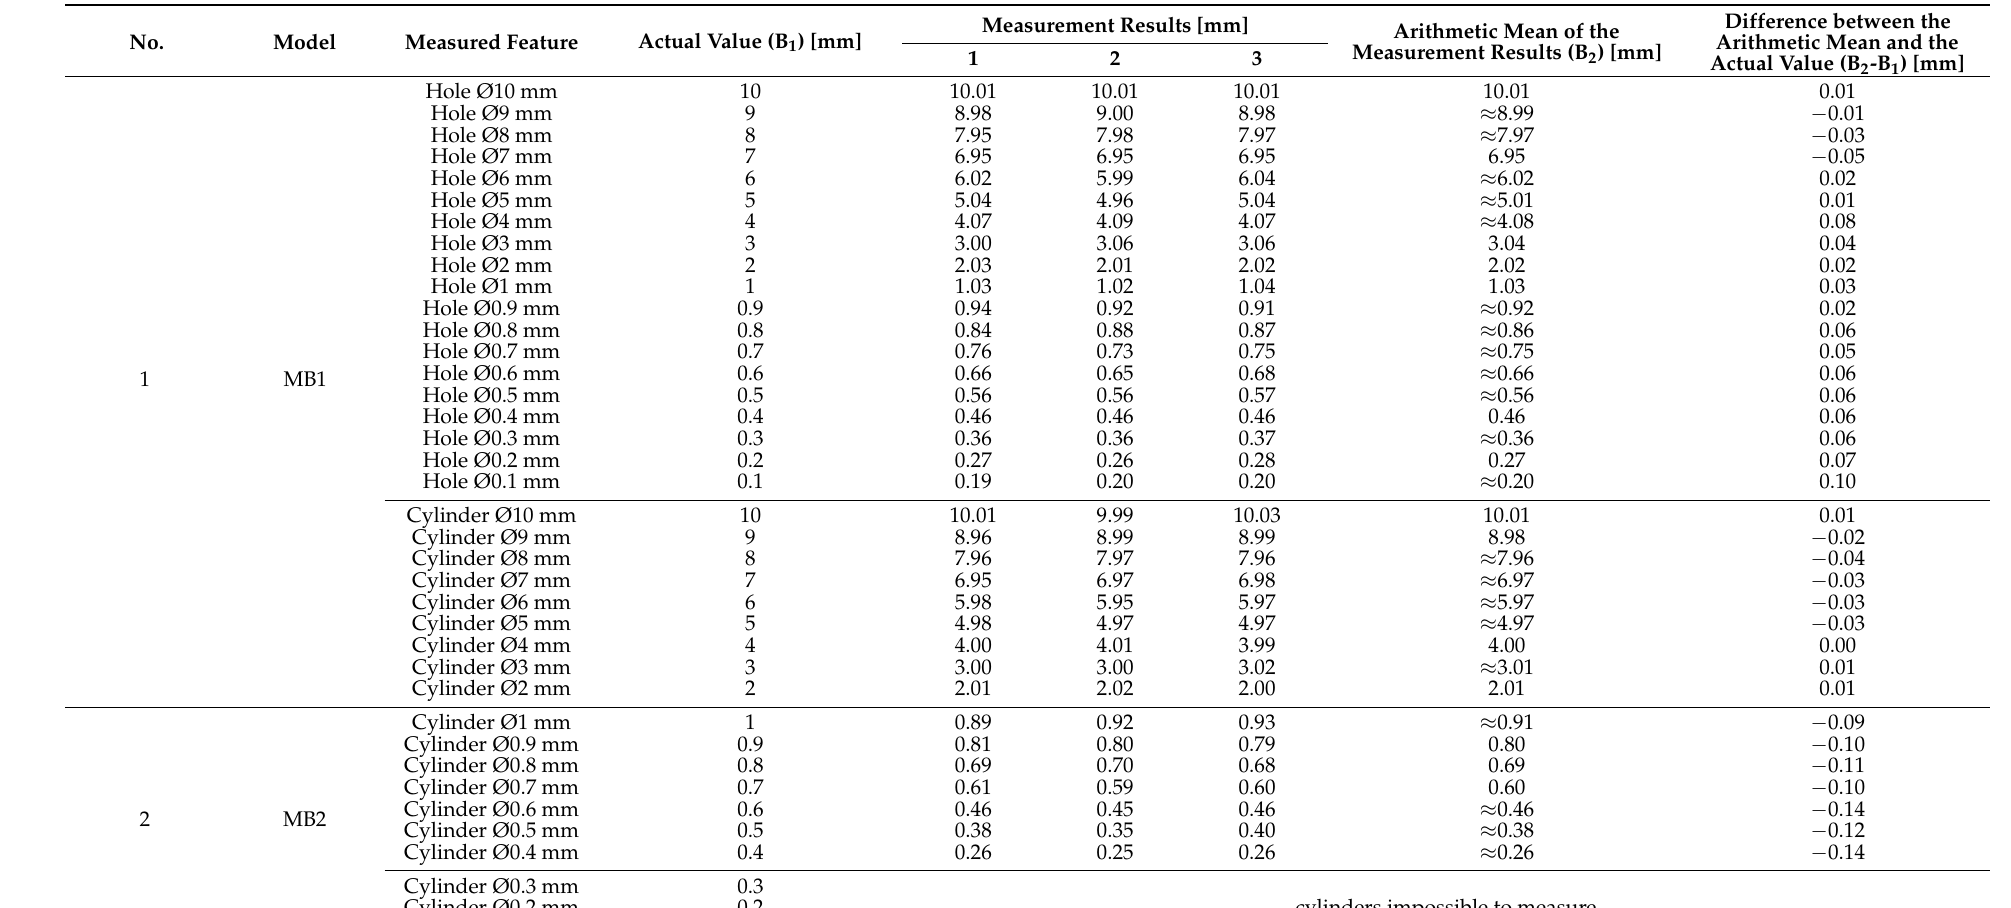
Table 6. Measurement results of the research models made in DMLS technology from 17-4 PH stainless